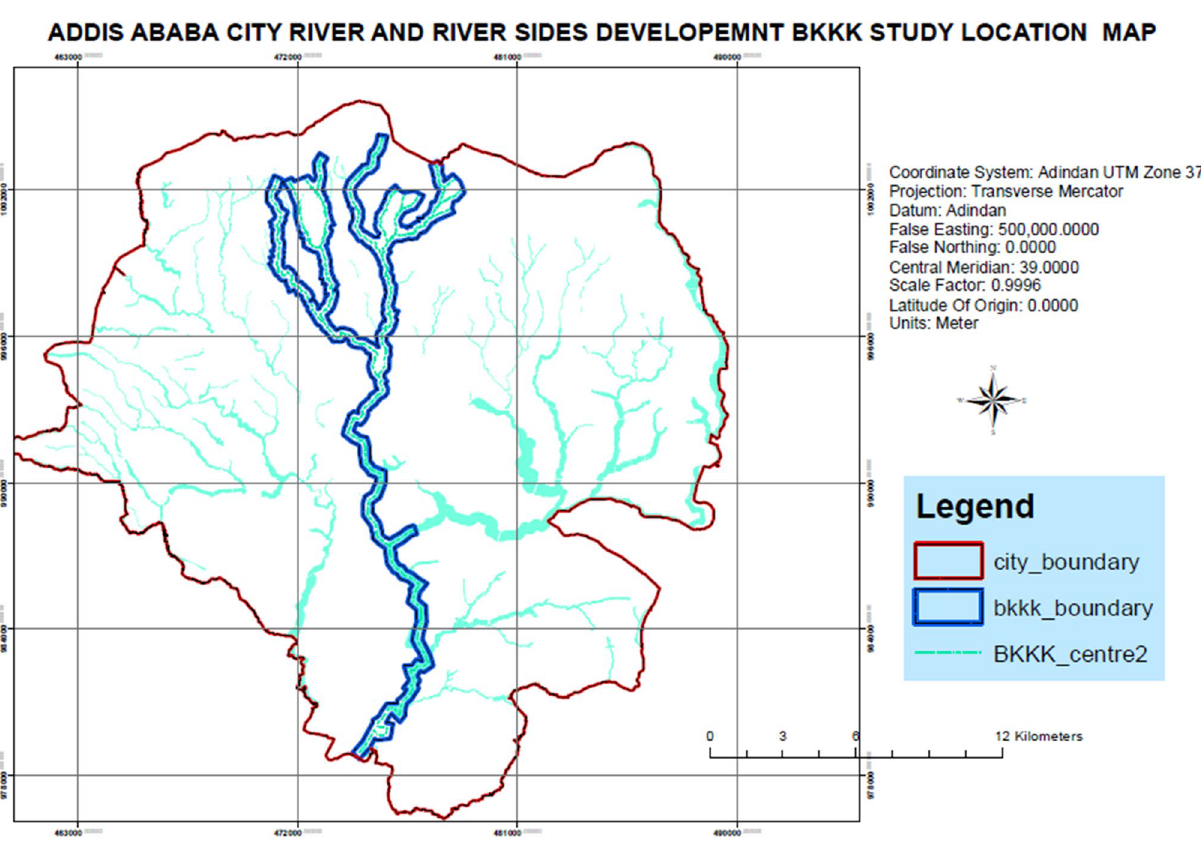
Fig. 4 Addis Ababa River and riversides development BKK + K study area. Source Addis Ababa City Rivers Riversides Development